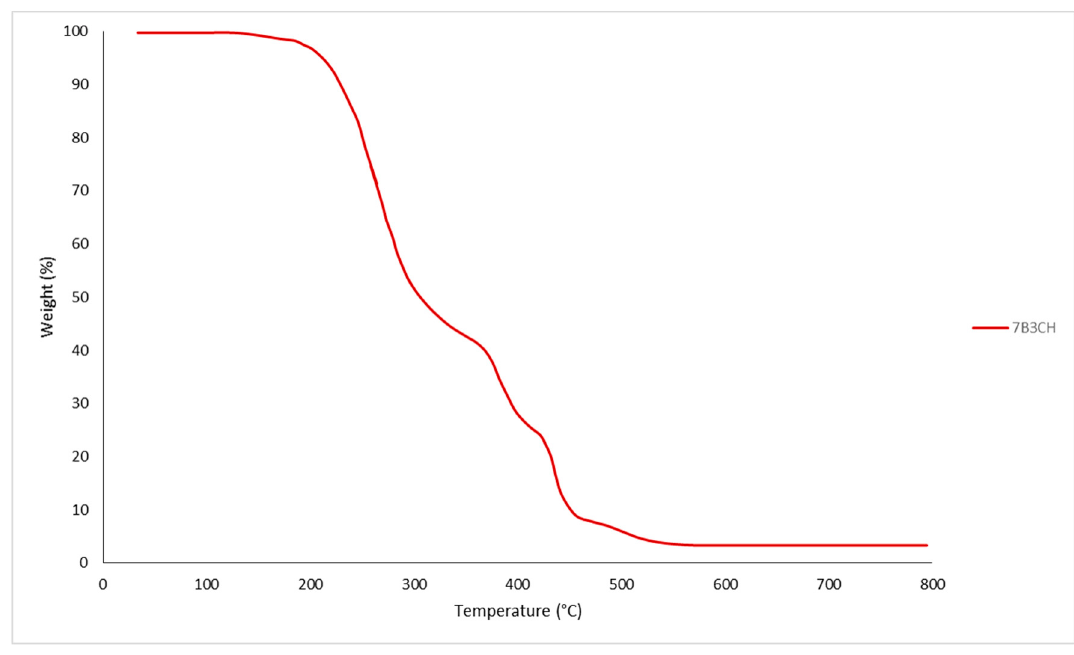
Figure 1. TGA analysis curve for stickies 7B3CH.